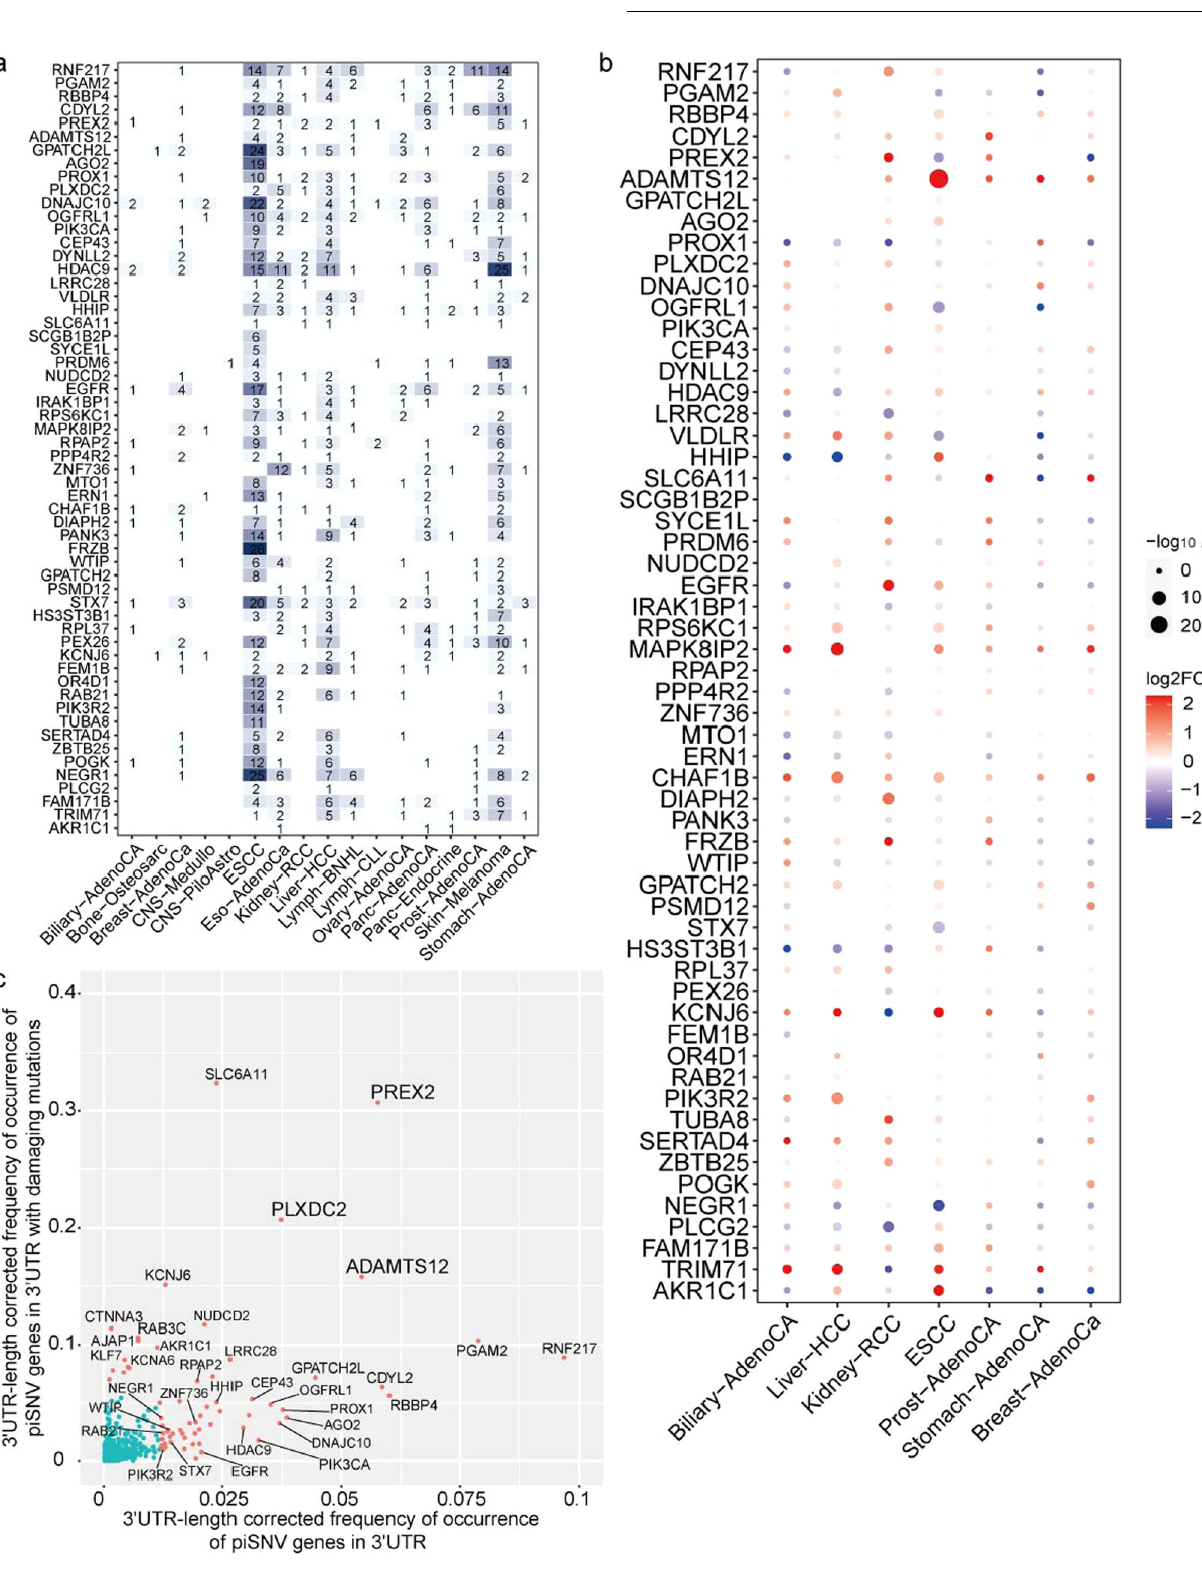
Fig. 5 Top 3 ′ -UTR piSNV-affected genes in PCAWG and ESCC cohorts. The cooccurrence ( a ) and expression ( b ) of the top 2% (58) 3 ′ -UTR- length corrected frequently occurred 3 ′ -UTR piSNV-affected genes in cancers. c The scatter plot displayed the 3 ′ -UTR-length corrected occurrence frequency of genes at protein and post-transcriptional regulation